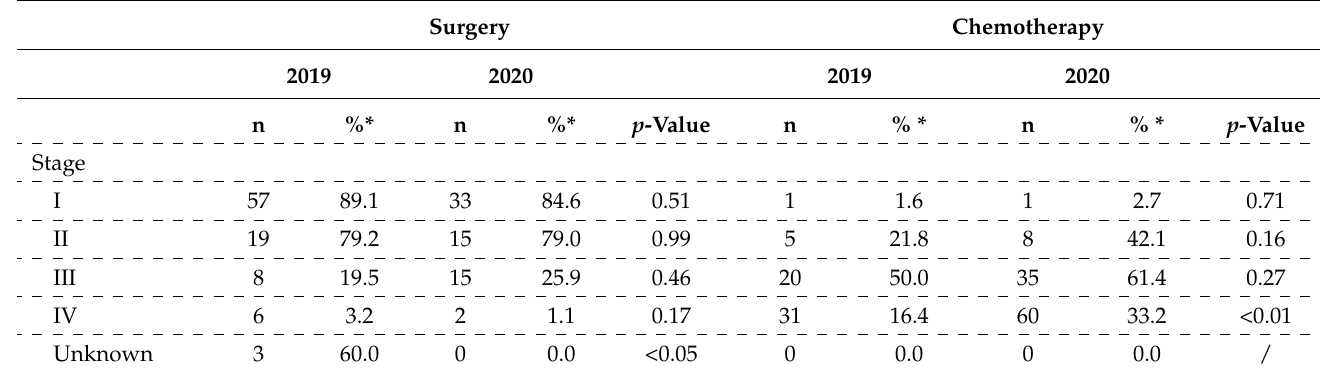
Table 2. Number of cases by stage and therapy per